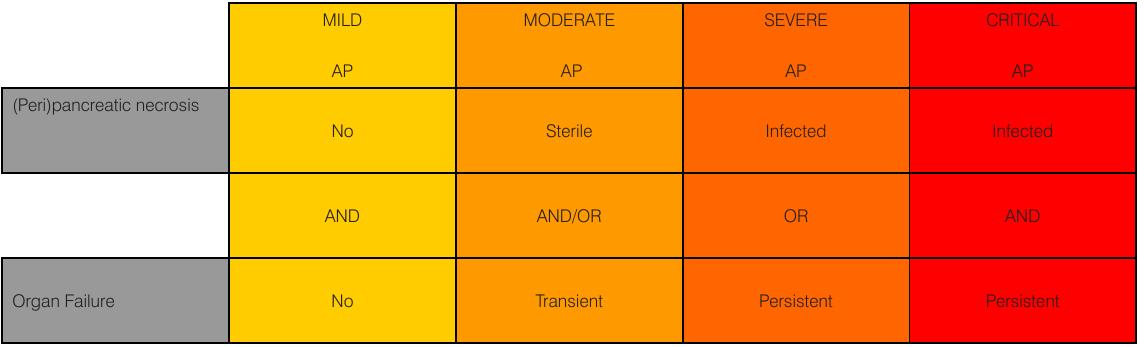
Table 3. Determinant-Based Classification of AP